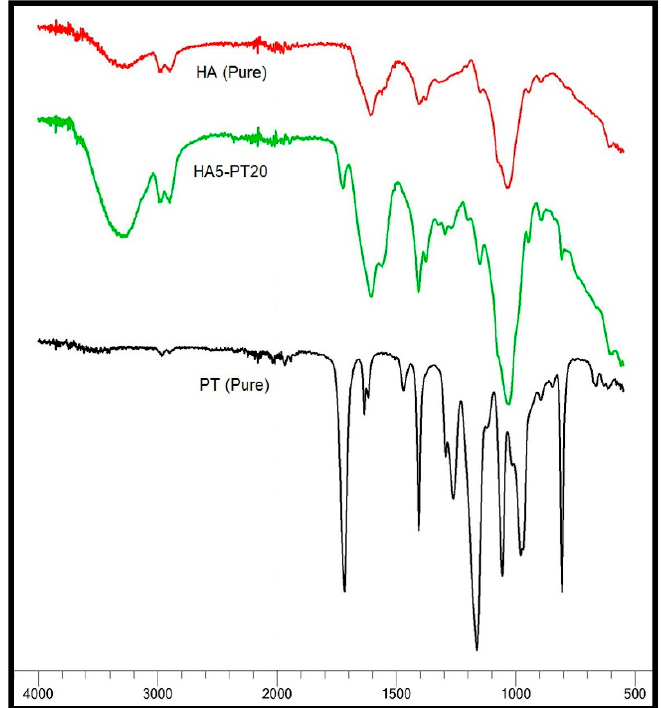
Figure 5. FTIR spectra of pure HA, cross-linked HA5-PT20, and pure PT.